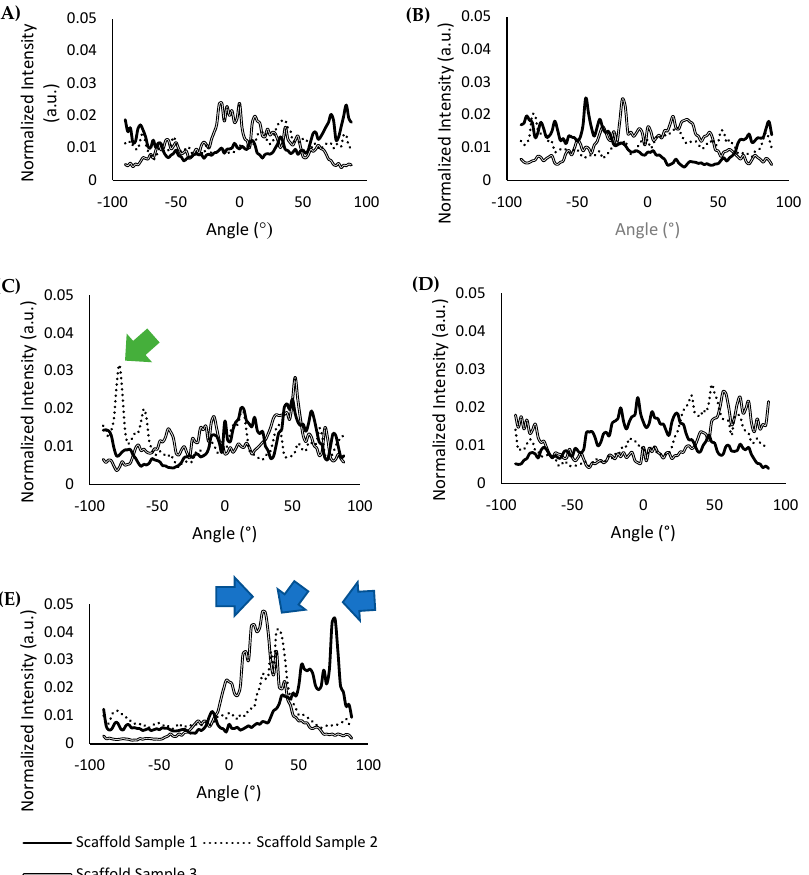
Figure 4. FFT analysis plot of the scaffold samples fabricated using their corresponding methods: ( A ) plain collagen scaffolds; ( B ) GMNP-incorporated collagen scaffolds without magnetic field treatment; ( C ) scaffolds fabricated with the “mag- netic particle string” method; ( D ) CMP-functionalised GMNP collagen scaffolds without magnetic field treatment; ( E ) scaffolds fabricated with the “magnetic anchor” method.